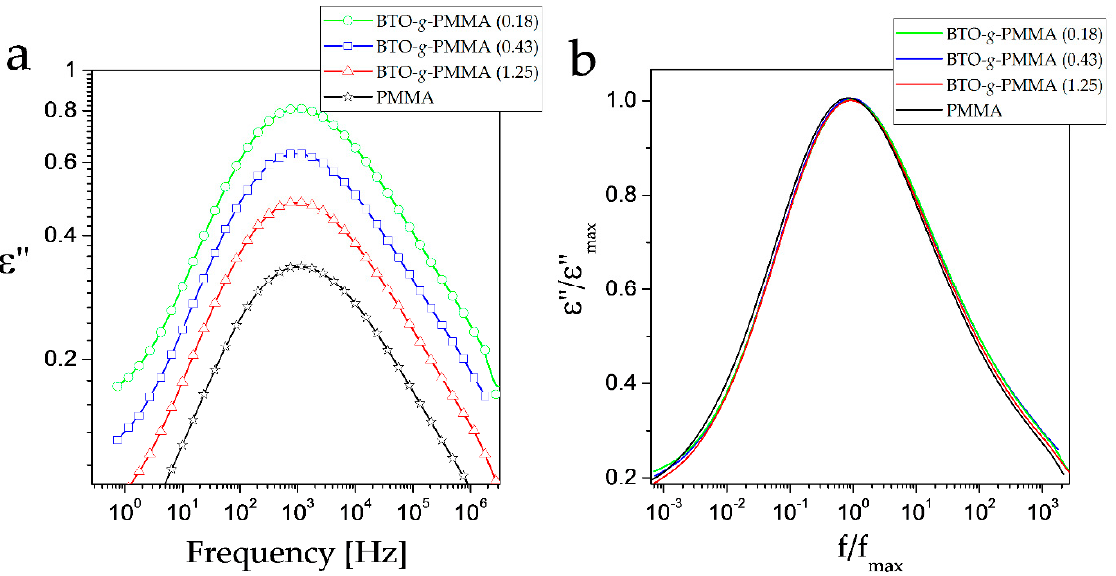
Figure 3. Frequency dependence of imaginary part of dielectric permittivity ( a ) and its normalized curves ( b ) for BTO- g -PMMA core–shell composites collected at 80 °C. Table 2. Havriliak–Negami (HN) parameters for β -relaxation processes in studied BTO- g -PMMA composites obtained from analysis of dielectric spectra at 80 °C. The data for neat PMMA was added for comparison.